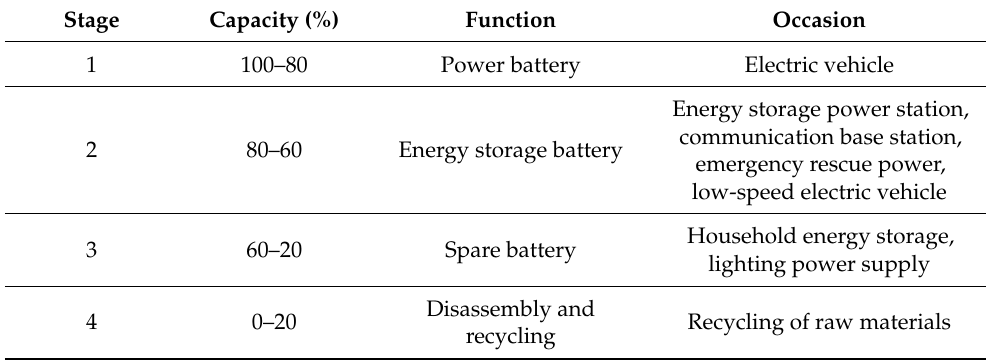
Table 3. Echelon utilization occasions of power batteries at different capacity